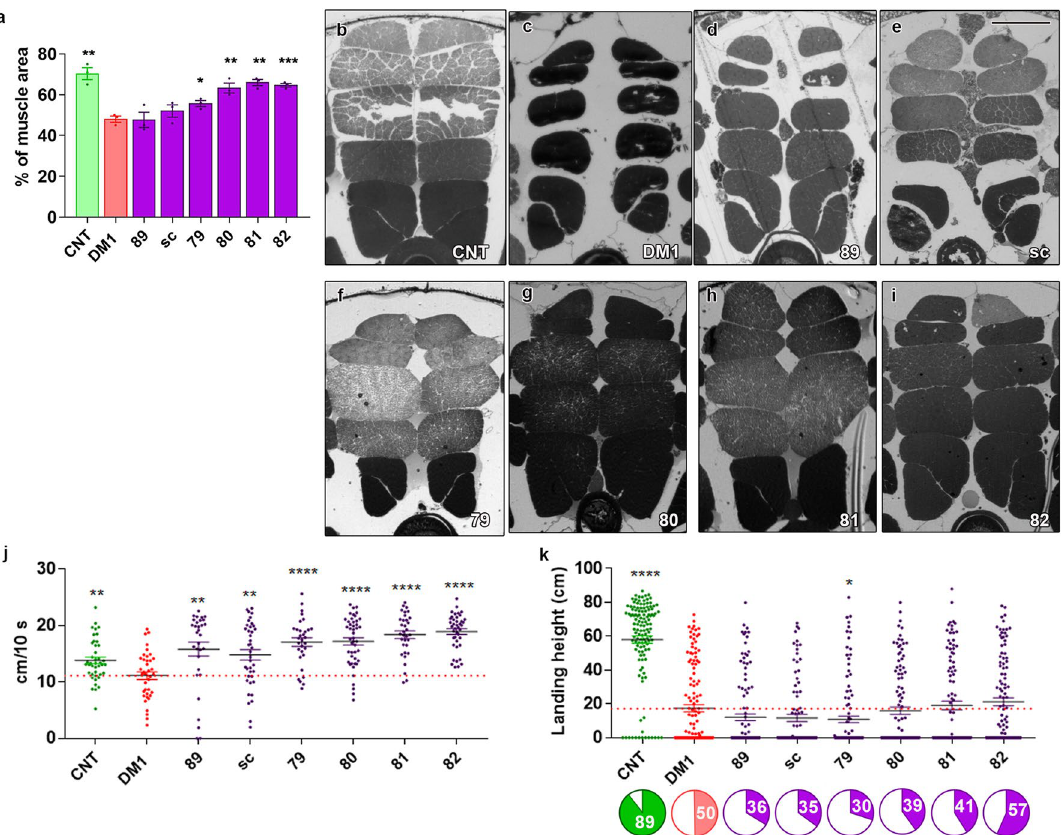
Figure 5. Candidate peptides rescued muscle atrophy in a Drosophila DM1 model. Quantification of indirect flight muscle (IFM) cross-sectional area ( a ) of control (CNT), DM1 flies taking vehicle (DMSO) and DM1 flies taking negative controls (89 or sc) or the indicated candidate peptides. All four candidate peptides increased the mean muscle area relative to DMSO-treated flies (6 flies and 6 micrographs per condition were analyzed). ( b – i ) Representative bright-field microscope images of transversal sections of resin-embedded adult IFM of Mhc- Gal4 UAS-i(CTG)480 (Rec2) heterozygous flies treated with DMSO (0.01%) or with peptides 79–82 (10 μM) that were used to generate the data shown in ( a ). Muscle recovery at the histological level leads to functional improvements. The climbing assay (n = 30; j ) showed a significant increase in the speed of the treated flies compared to the untreated ones, calculated as the distance traveled in 10 s. In the flight assay (n = 100; k ), the average value of the landing height did not significantly improve, but there was a clear increase in the percentage of flies that were able to fly (colored sectors in pie charts underneath the graph), especially for flies treated with peptide 82. *p < 0.05, **p < 0.01, ***p < 0.001 according to Student’s t-test. Scale bar for ( b )–( i ) panels measures 100